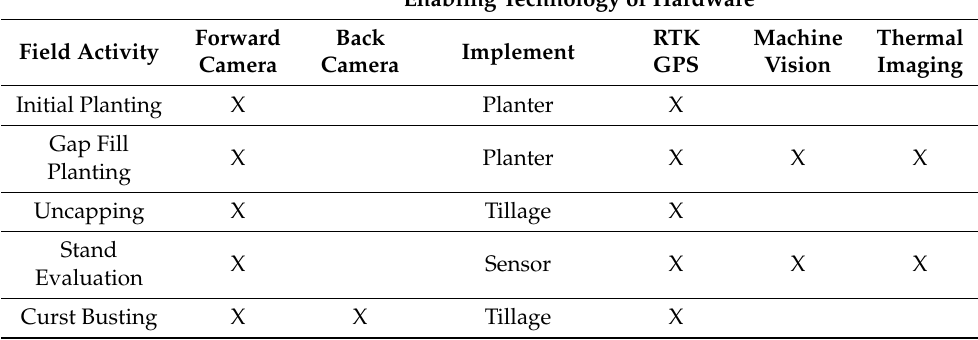
Table 3. Field and gin activities that could benefit from automation and technology and/or hardware needed for